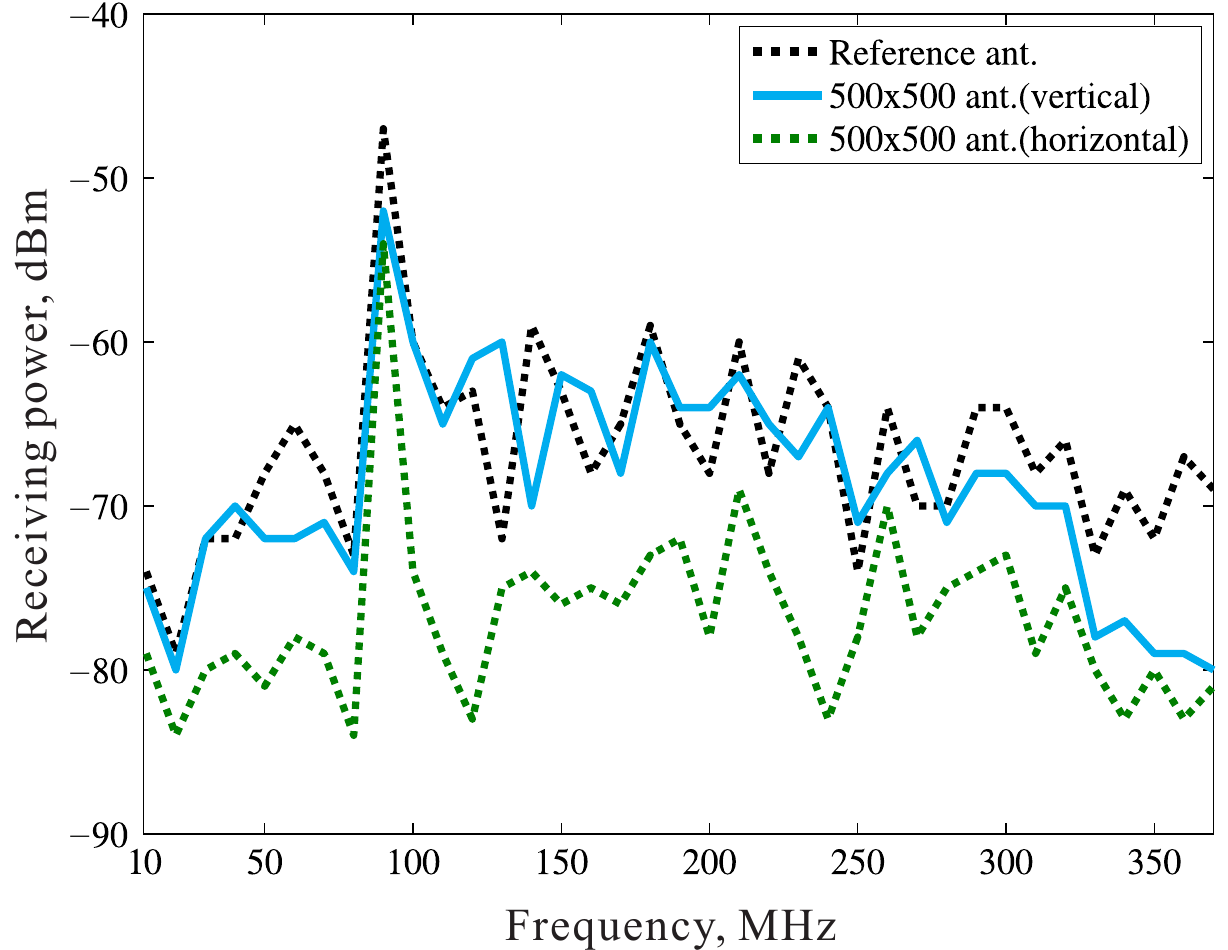
Figure 12. Measured received power of a proposed antenna and reference